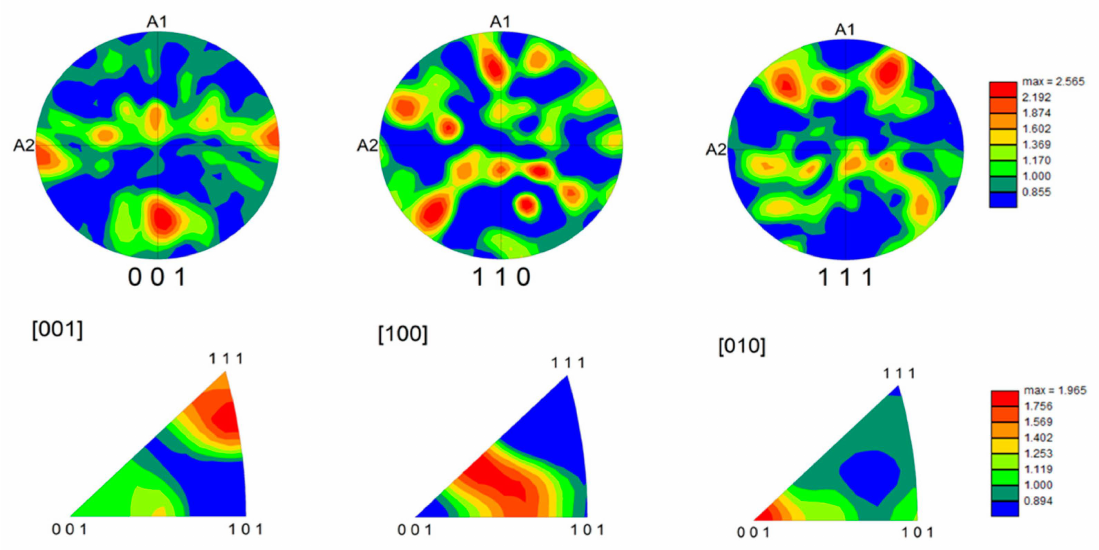
Figure 3. Pole figure and inverse pole figure analysis of 7075 aluminum alloy.